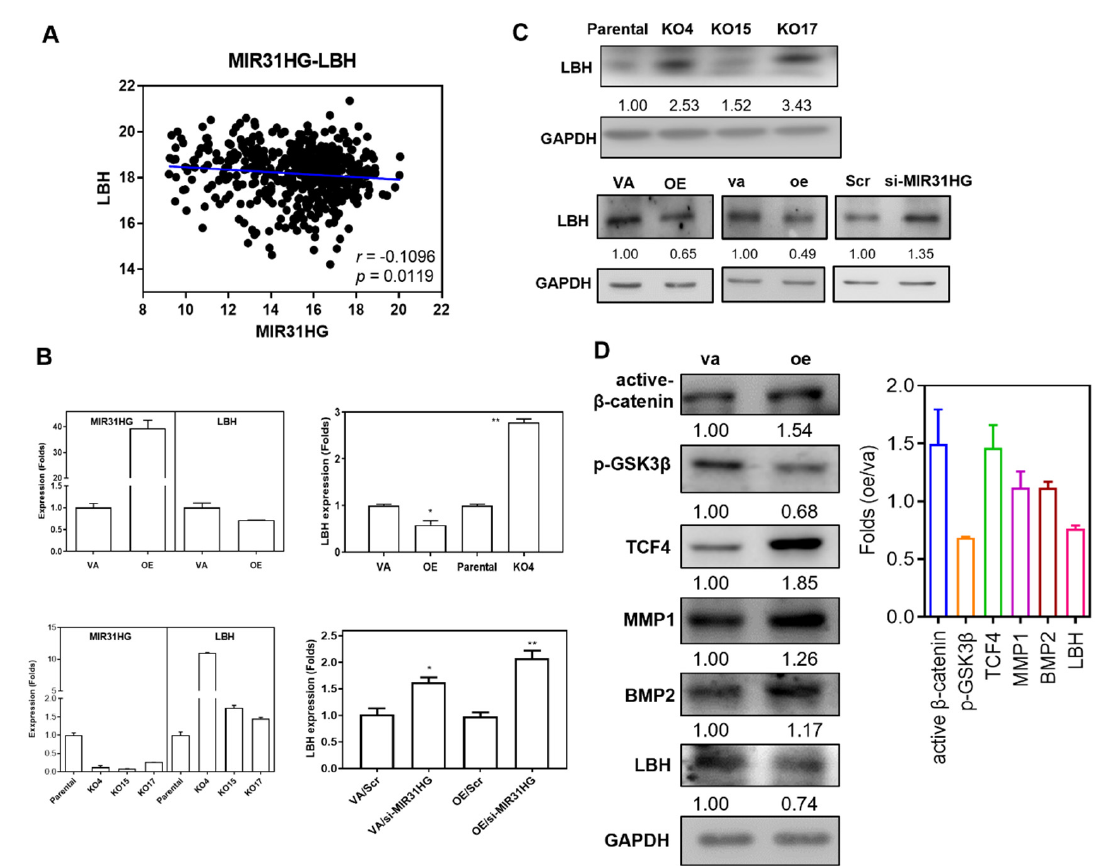
Figure 6. LBH is a negative effector of MIR31HG . ( A ) A weakly negative correlation between expression of MIR31HG and LBH can be seen in HNSCC tumors from the TCGA dataset. ( B ) qRT-PCR analysis. Upper, decreased LBH expression in MIR31HG overexpression cells, and increased LBH expression in the MIR31HG knockout cell subclone. Lower Left, decreased MIR31HG expression and increased LBH mRNA expression in the MIR31HG knockout cell subclones. Lower Right, knockdown of MIR31HG increases LBH expression in both VA and OE cells. At least duplicate analysis. ( C ) Western blot analysis. Upper, increased LBH expression in MIR31HG knockout cell subclones. Lower, both stable and transient MIR31HG overexpression decreases LBH protein expression, whereas knockdown of MIR31HG increases LBH protein expression. ( D ) Western blot analysis. Left, a representative analysis. Transient MIR31HG overexpression activates Wnt signal molecules, increases MMP1 and BMP2 expression, as well as decreasing LBH expression. Right, quantification of duplicate or triplicate analysis. VA or va, vector alone. OE, stable MIR31HG overexpression. oe, transient MIR31HG overexpression. Scr, scramble. *, p < 0.05; **, p <